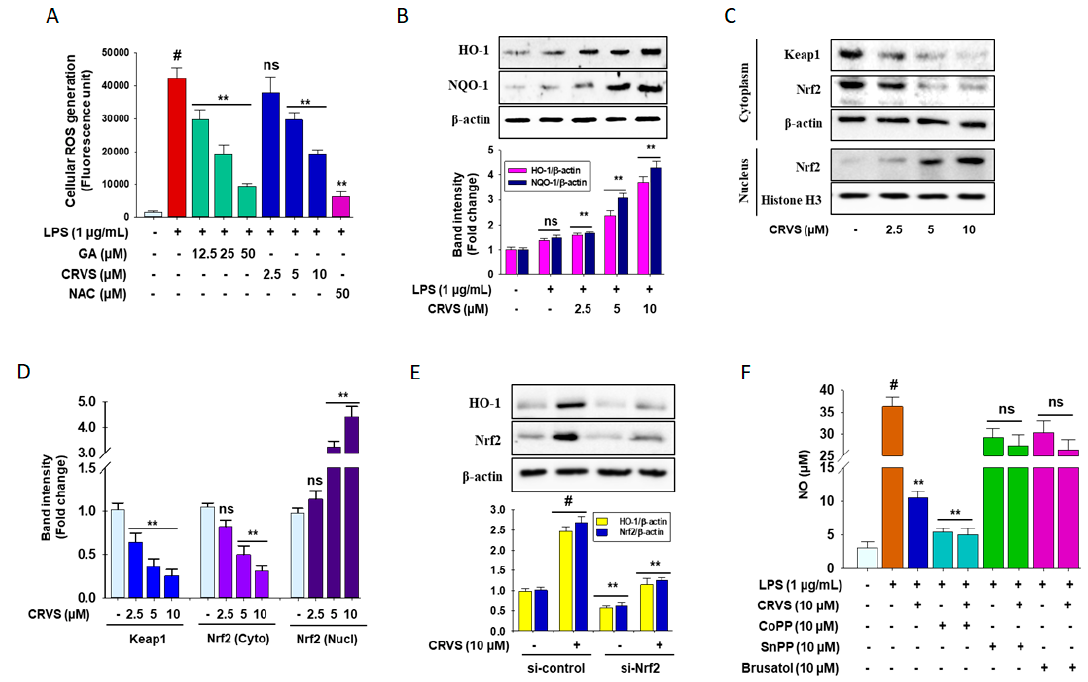
Figure 4. The antioxidant effects of CRVS in RAW 264.7 cells. Cells (1 × 10 5 cells/mL) were seeded in a 6-well plate and incubated for 24 h. Then, the cells were treated with indicated concentrations of CRVS (2.5–10 μ M) or vehicle alone for 24 h. Effects of CRVS on scavenging of intracellular reactive oxygen species (ROS) ( A ); the expression of heme oxygenase 1 (HO-1) and NAD(P)H quinone dehydrogenase 1 (NQO-1) ( B ); Kelch-like ECH-associated protein 1 (Keap-1), and nuclear factor erythroid 2-related factor 2 (Nrf2) in both cytosol and nuclear fractions ( C ) was detected by Western blot analysis. Densitometric analysis was carried out to assess the quantification of the relative band intensities ( D ). Cells were treated with the siRNA for Nrf2 (si-Nrf2) with and without CRVS according to the protocol described in materials and methods, and protein levels of Nrf2 and HO-1 were analyzed by immunoblotting ( E ). The production of NO was measured using a Griess reagent assay (F). # p < 0.01 as compared with vehicle-treated control; ** p < 0.05 as compared with LPS alone.